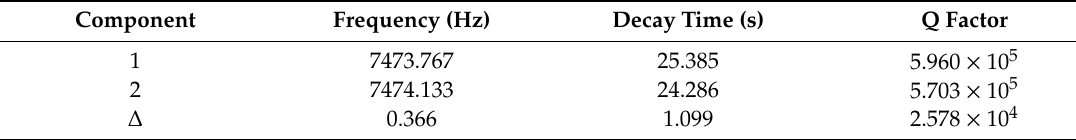
Table 2. The VCMs detected by the laser Doppler